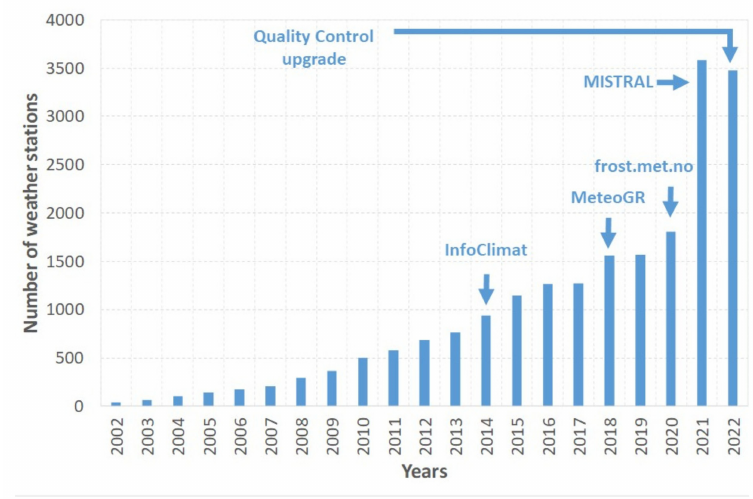
Figure 2. Sum of weather stations constantly online on the MNW webpage during day. The bins before the year 2006 are referred to the number of weather stations online at least once every 24 h. Currently, the data stream generated by the Italian stations on MNW averages almost 6 records per second (518,000 data records per day, 21,583 records per hour). Figure 3 shows the sampling frequency of the operative MNW stations in Italy, on average, during the month of January 2022 (1134 stations). The range of the sampling frequency for each instantaneous datum spans between a minimum of 1 min up to 60 min, and most of the stations have a sampling frequency in the range from 3 to 5 min.